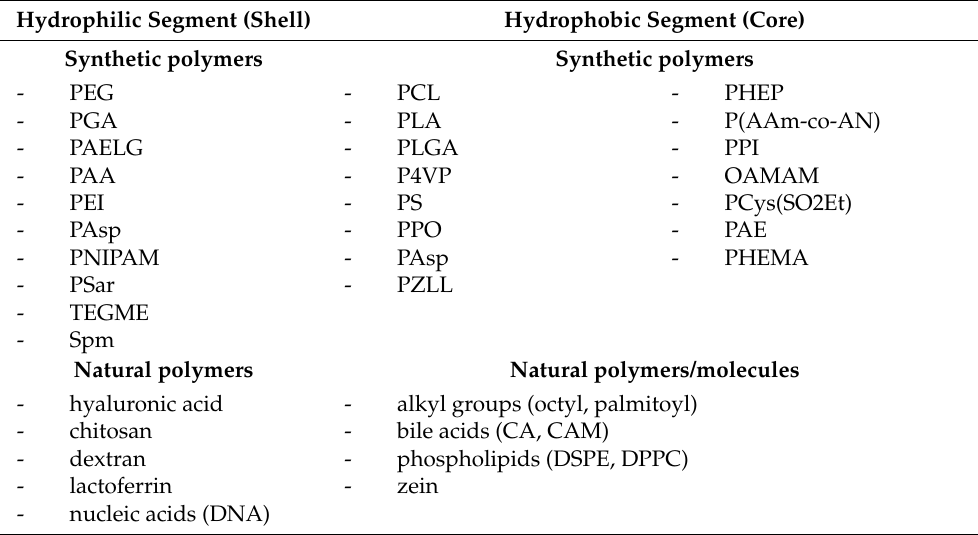
Table 1. Building block materials for the hydrophilic and hydrophobic segments of magnetic poly- meric